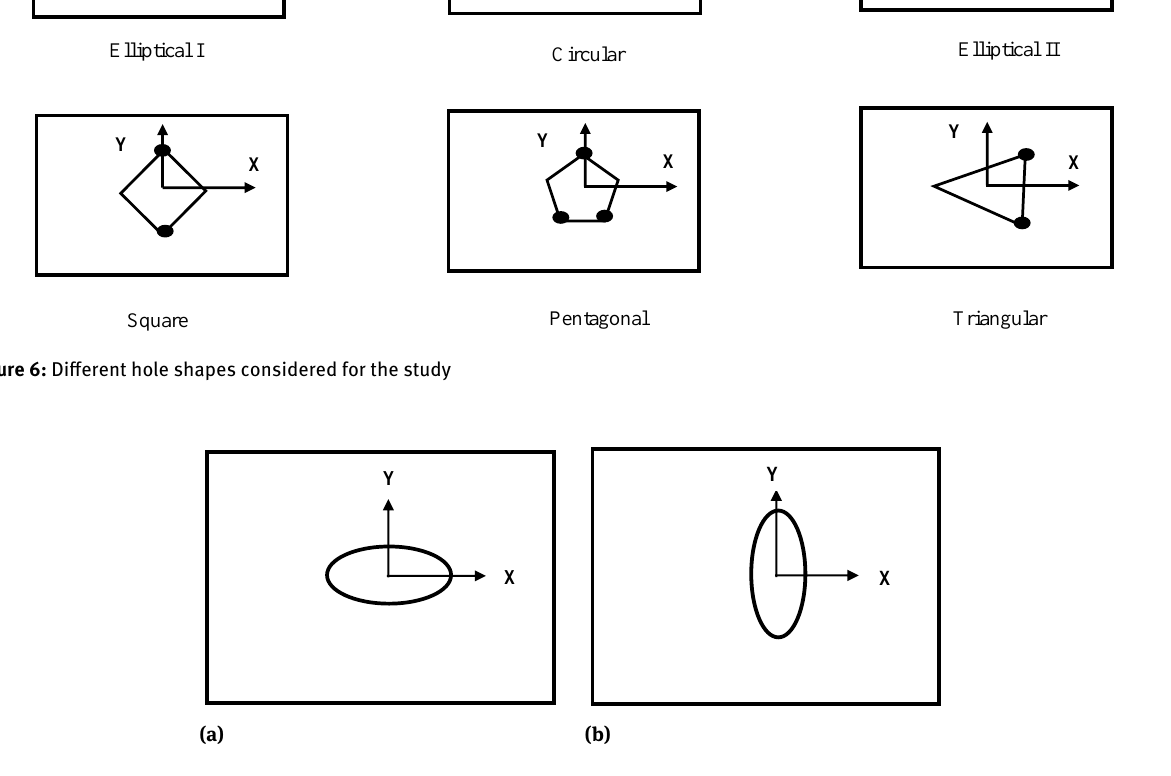
Figure 7: Composite plate with a hole of (a) Elliptical I and (b) Elliptical II shape